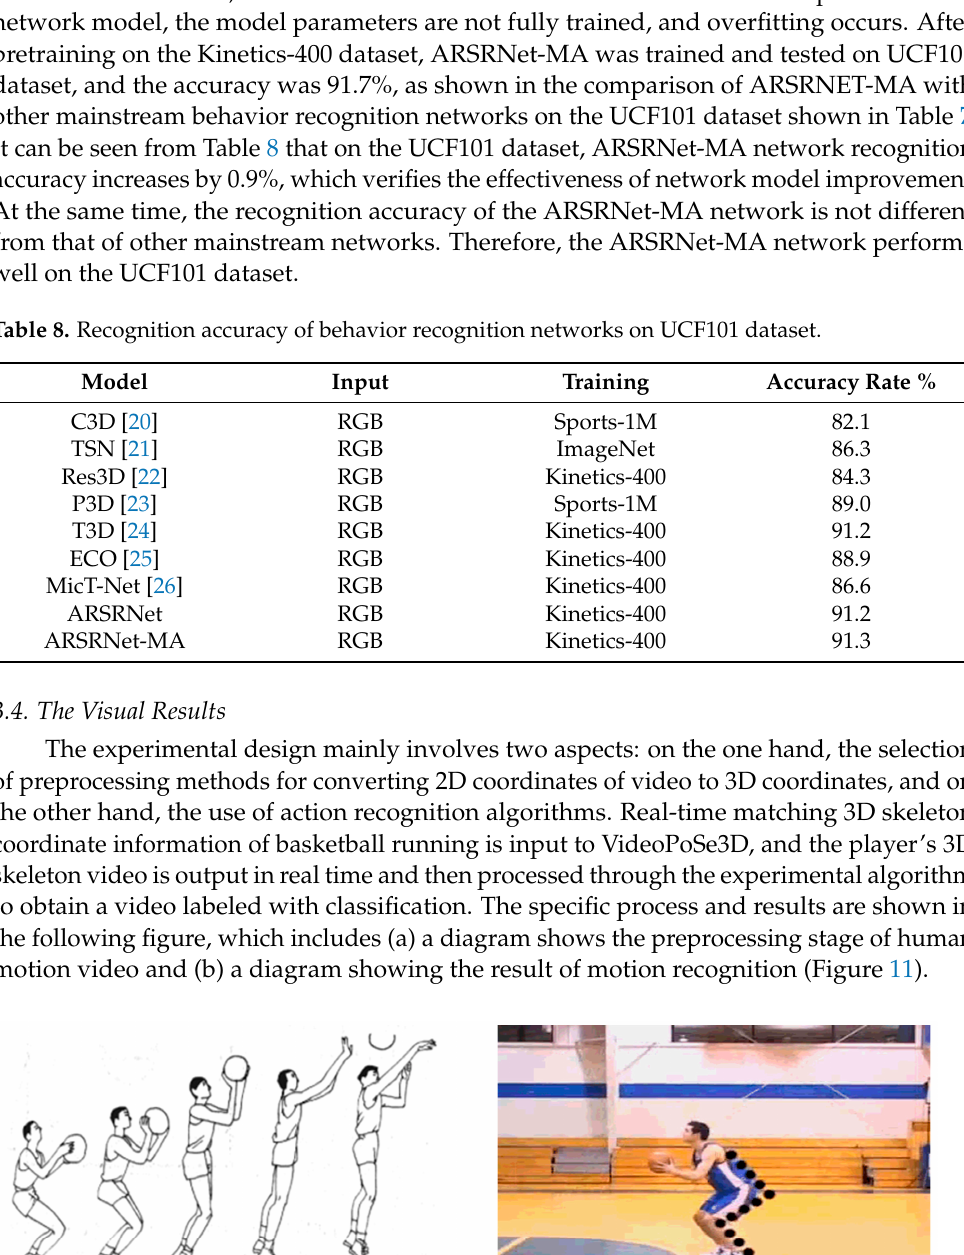
Table 7. Comparison of attention modules on MSC0C0 dataset.